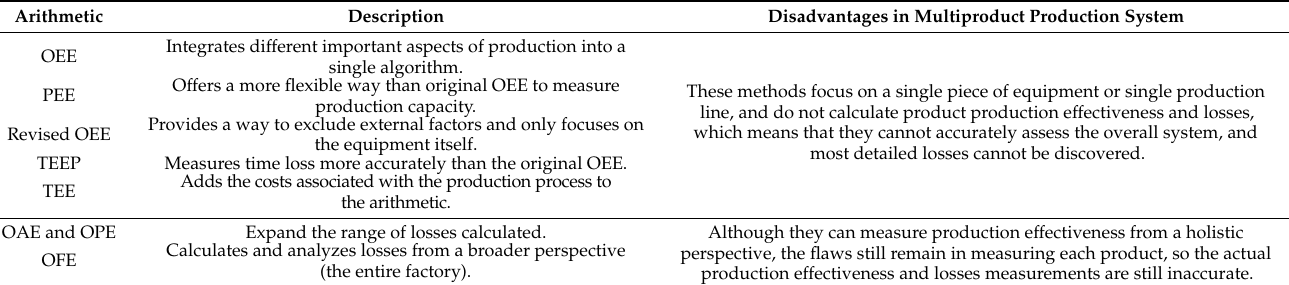
Table 2. Descriptions and disadvantages of mainstream OEE measurement methods.